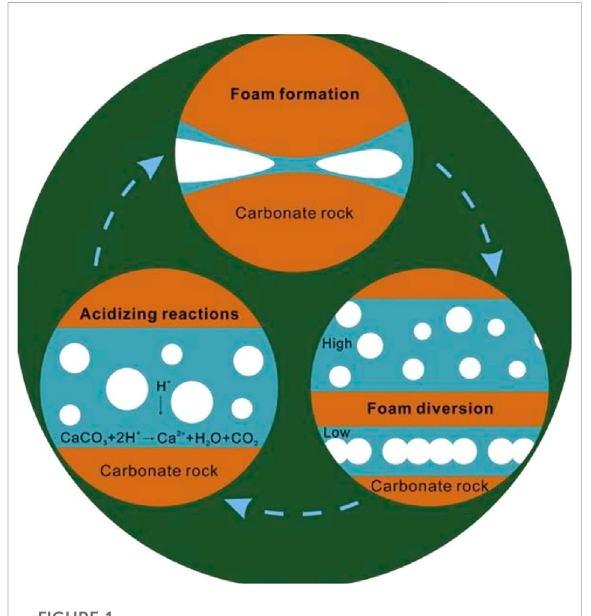
FIGURE 1 Induced acid diversion by foam-based acid (Yan et al.,